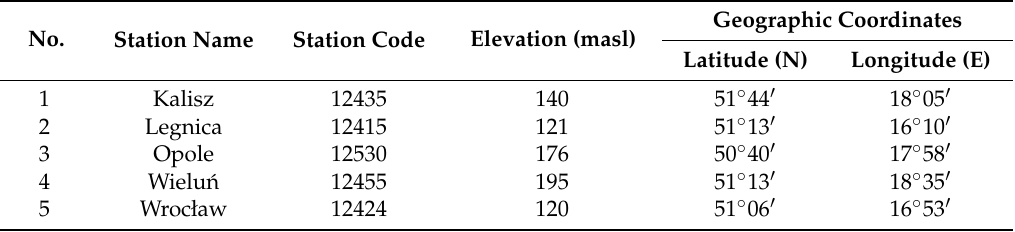
Table 1. Characteristics of the location of meteorological stations used in the study.